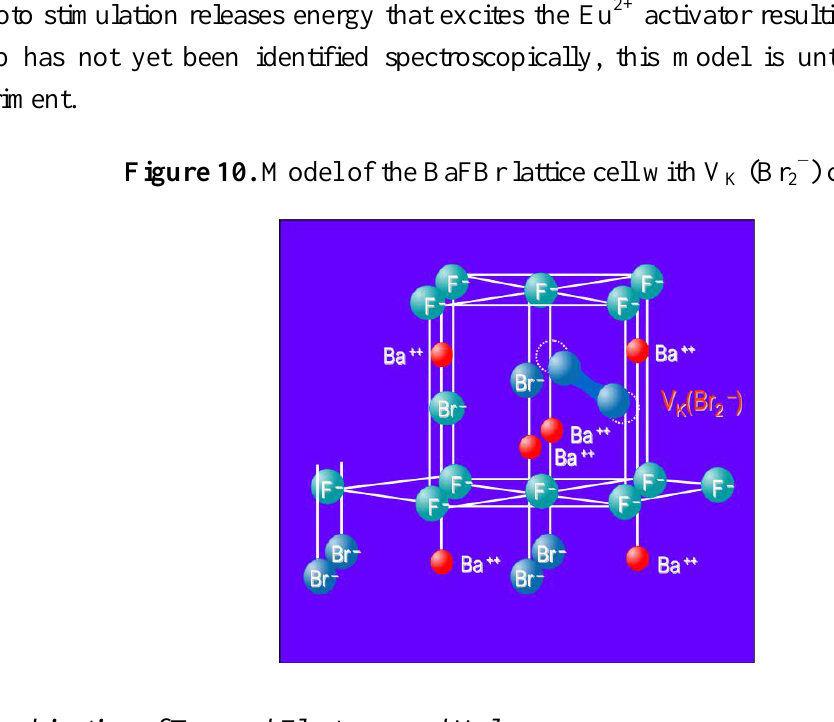
Figure 10. Model of the BaFBr lattice cell with V